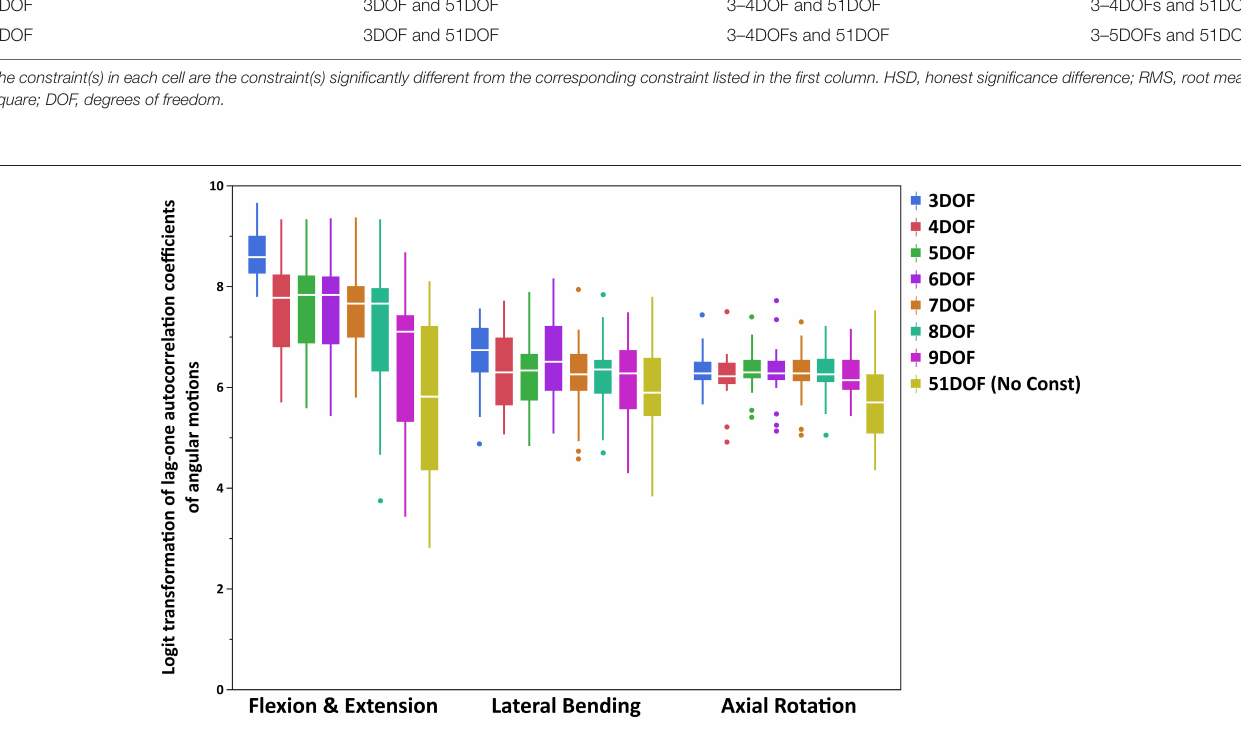
Frontiers in Bioengineering and Biotechnology |